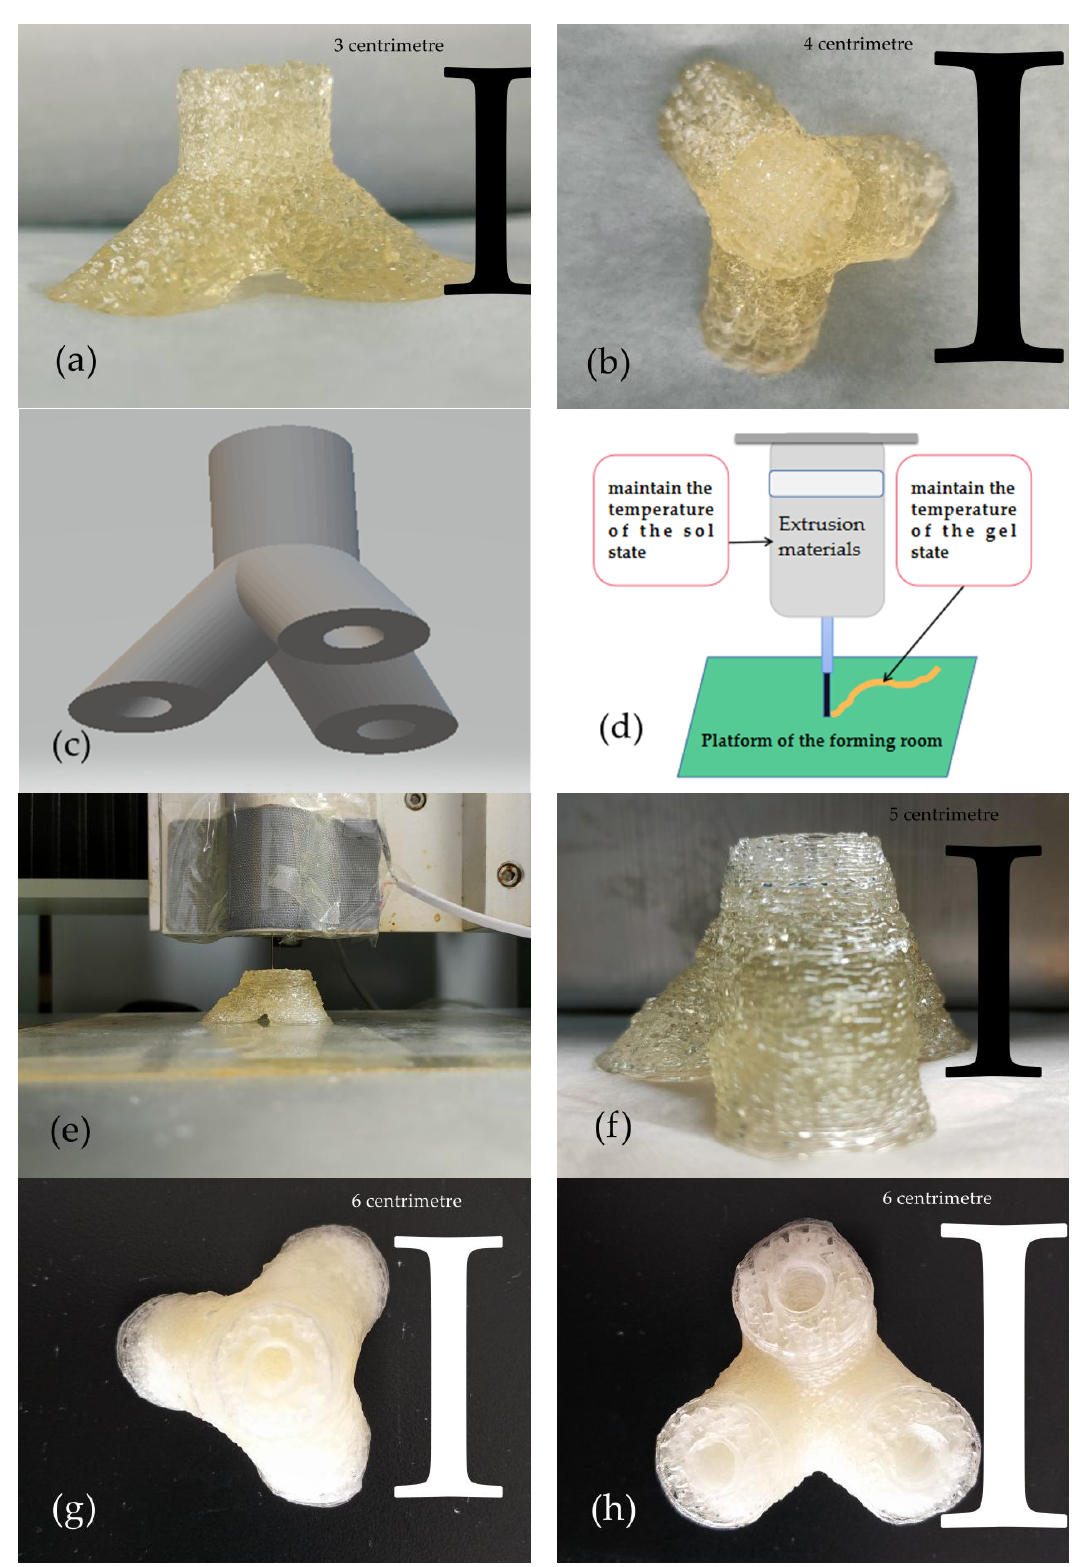
Figure 11. ( a ) Front view of solid structure. ( b ) Top view of solid structure. ( c ) Hollow trigeminal vascular structure model. ( d ) Schematic diagram of extrusion printing. ( e ) A shape view of the hollow, trigeminal vascular structure with a heating plate. ( f ) Front view of the hollow trigeminal vascular structure. ( g ) Top view of the hollow trigeminal vascular structure. ( h ) Bottom view of the hollow trigeminal vascular